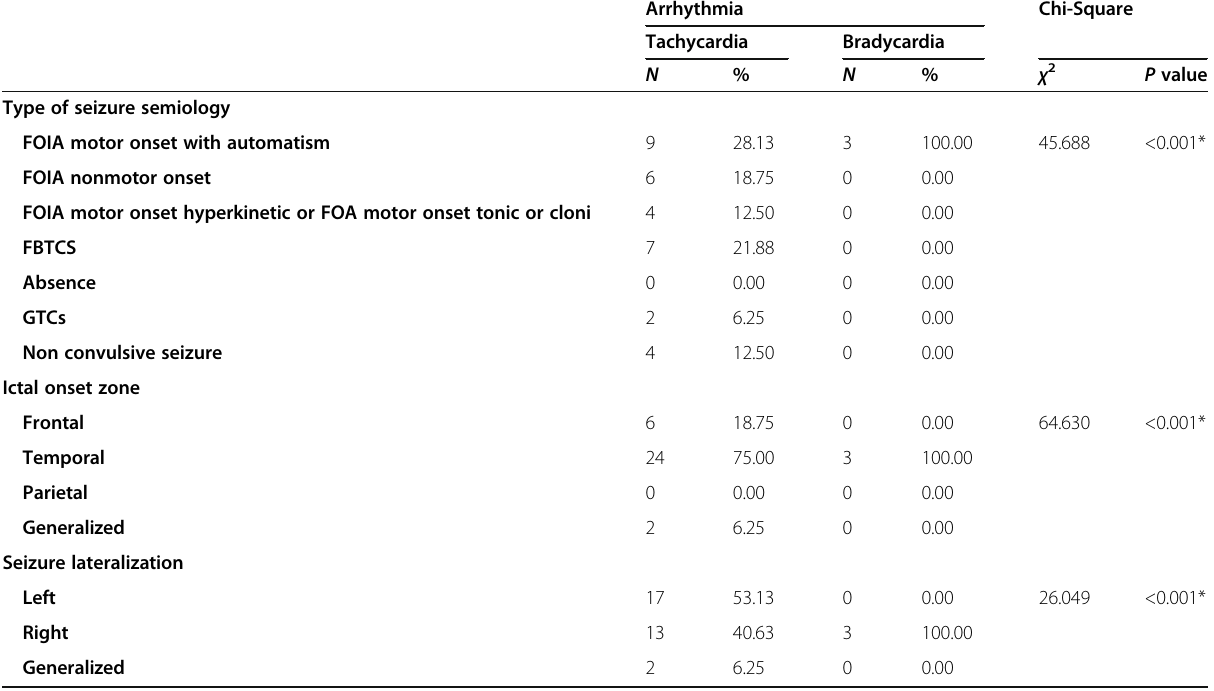
Table 5 Correlations between heart rate changes and seizure semiology, lateralization, and ictal onset zone